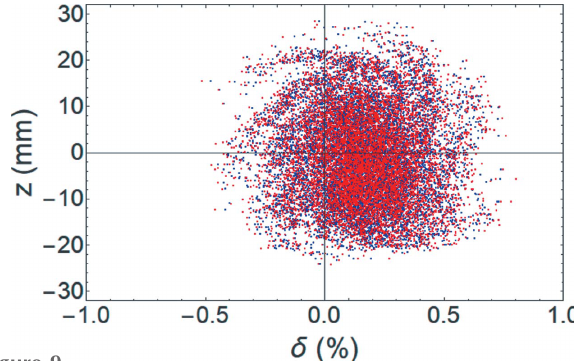
Figure 9 Comparison of the original longitudinal profile at the crab cavity position (blue dots) and re-projection of the x–y profile at the monitor position using equation (4) (red dots). Wakefield is included for a single bunch of 15